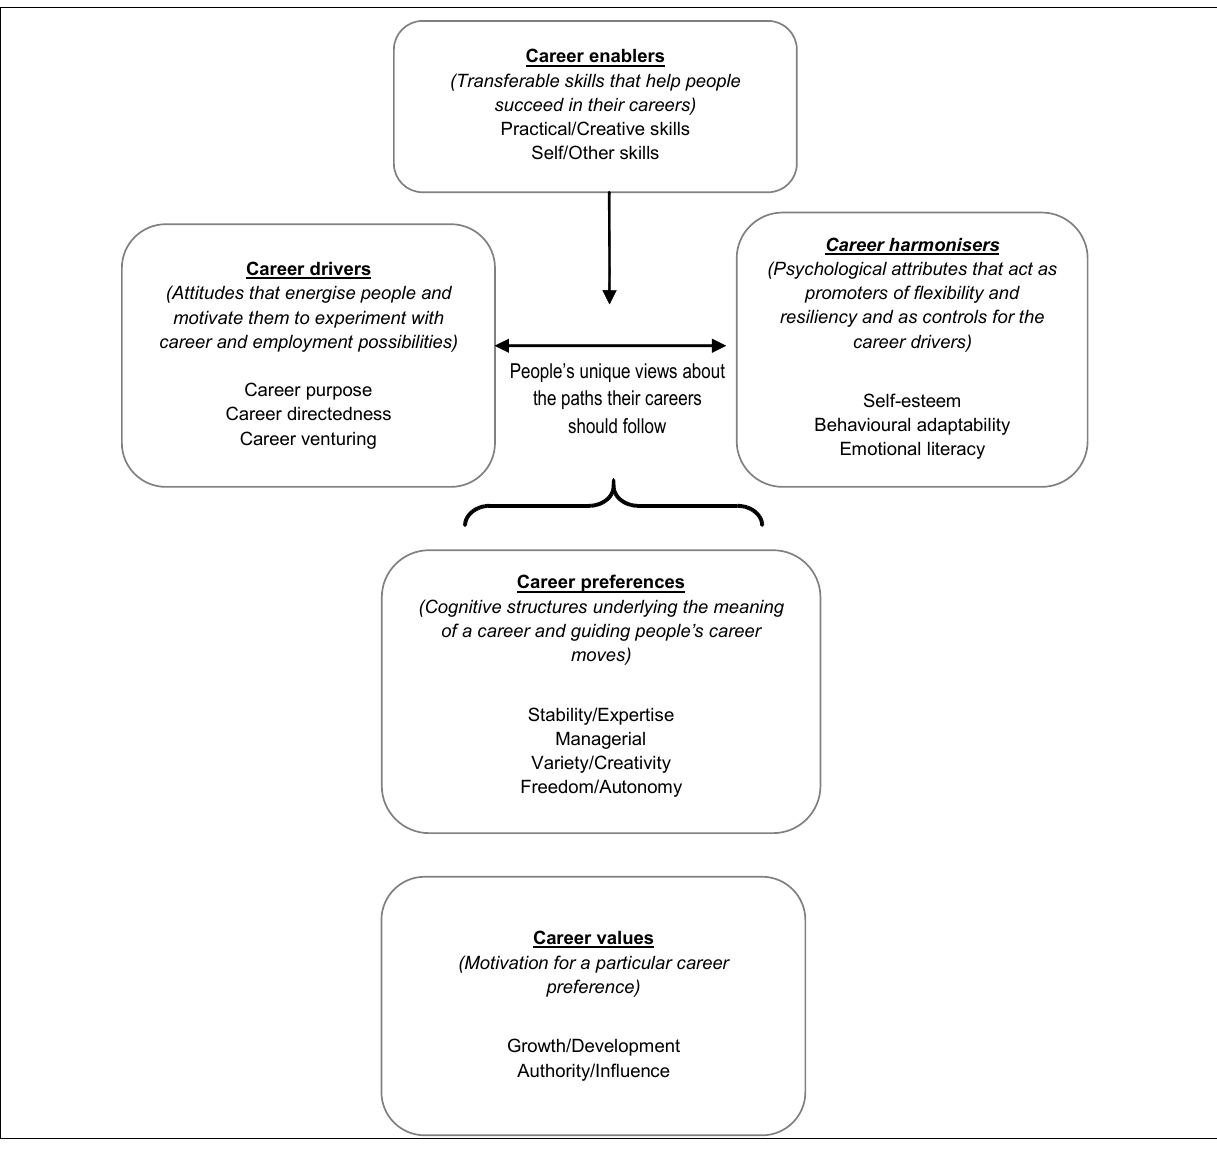
FIGURE 1 A theoretical framework of the construct psychological career